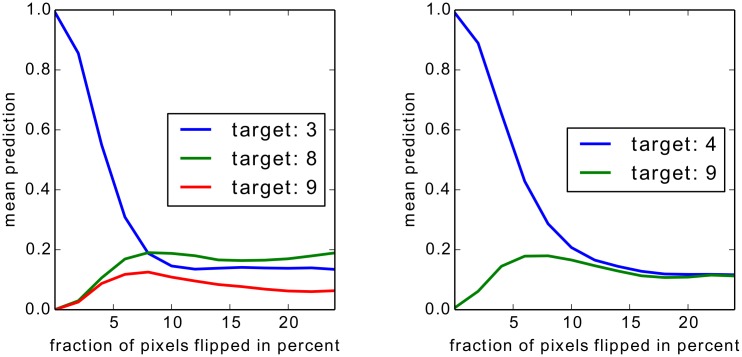
Flipping of digit and non-digit pixels with positive responses.Pixels with highest positive scores are flipped first. The pixel-wise decomposition was computed for the true digit classes three (left) and four (right).